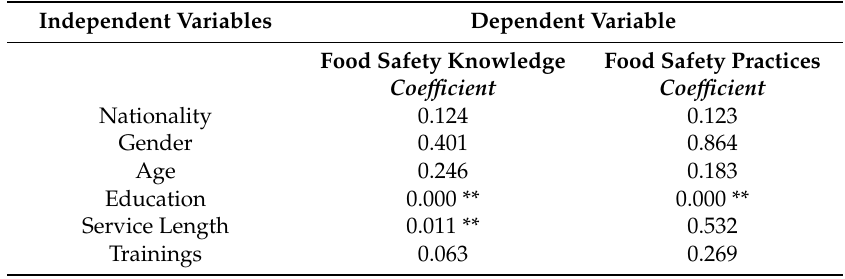
Table 11. Influence of demographic characteristics on food safety knowledge on food safety practice using a linear regression